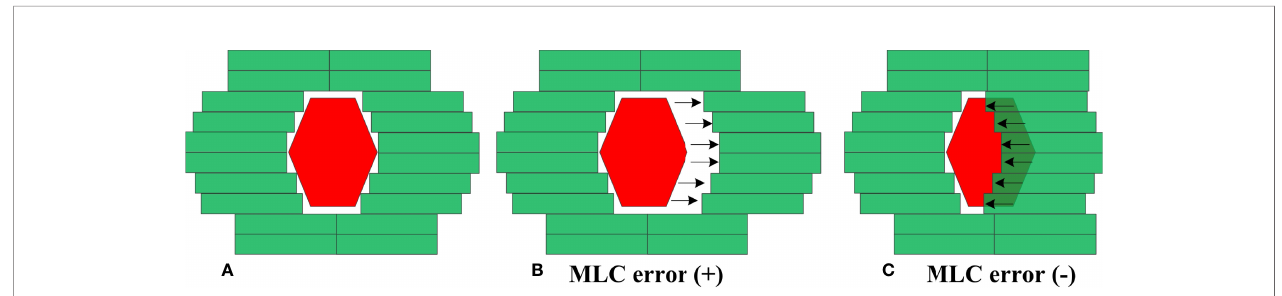
FIGURE 2 | Creation of MLC error-induced RapidArc plan. (A) original plan (B) error-induced plan with positive MLC errors (C) error-induced plan with negative MLC